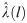
Statistical trends of λ^(l) mean and PWF frequencies from partitions S6 and S7.Statistical trends were estimated in forty transgenerational methylome variants from Arabidopsis thaliana [19,35] considering all CDM contexts. (A) and (B), exponential region of λ^¯(l)
vs l in the range of PWF from 5 to 70 nm for the partitions S6 and S7, respectively. (C) and (D), exponential regions of λ^¯(l)
vs l in the range of PWF from 5 to 80 nm for the partitions S6 and S7, respectively. The exponential behavior is consistent with Eqs 22 and (23), which permits the estimation of the DNA persistence length Lp by means of Eq 24. (E) and (F) correspond to barplots for the annotated PWFs from linear regions presented in the panels A and B, respectively (4 to 100 bp ~ 34 nm). The relative frequencies of PWFs were normalized taking into account the overall length of the genomic region occupied by each genomic feature (promoter, exons, transposable elements (TEs), intergenic, etc) in the Arabidopsis thaliana genome. The exponential decay law predicted by Eq 33 was verified (subplots mean of PWF-frequency (f) vs l in panels A to D). The estimated value of the Helmholtz free energy ΔF = RT lnZ(γ) (Eq 34) at 298.15 K of temperature is indicated.